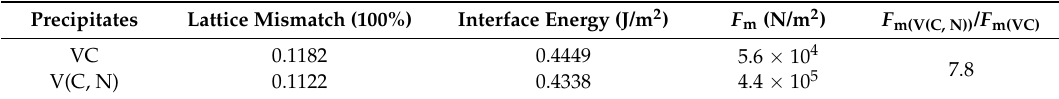
Table 5. Thermodynamic calculation